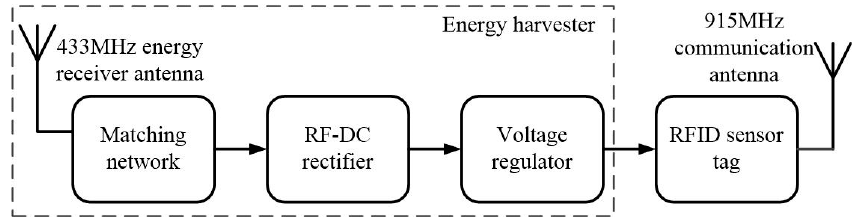
Figure 2. Block diagram of double ‐ antenna radio frequency identification (RFID) sensor tag.